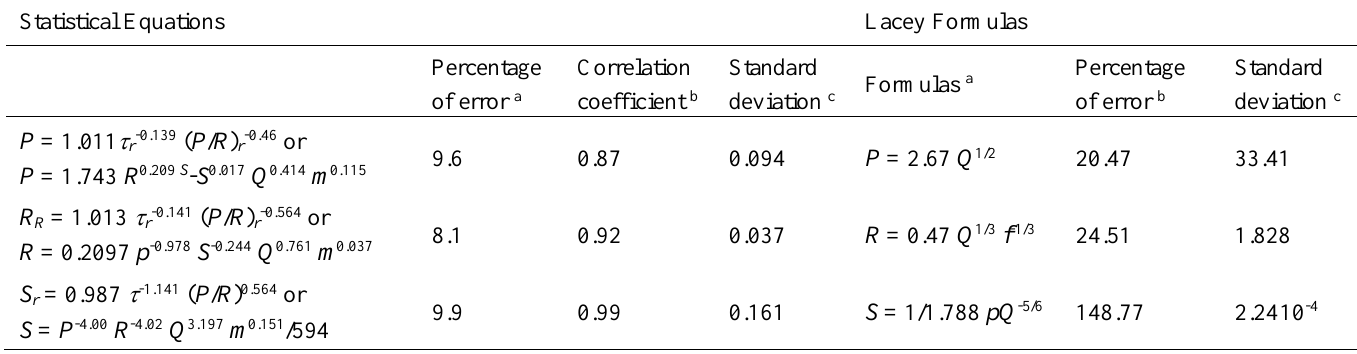
Comparison of Statistical and Lacey Equations Statistical